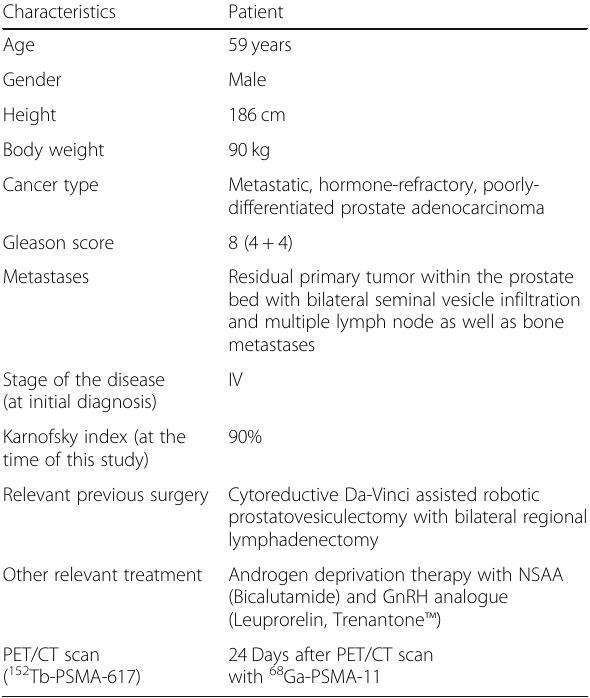
Table 1 Characteristics of the patient